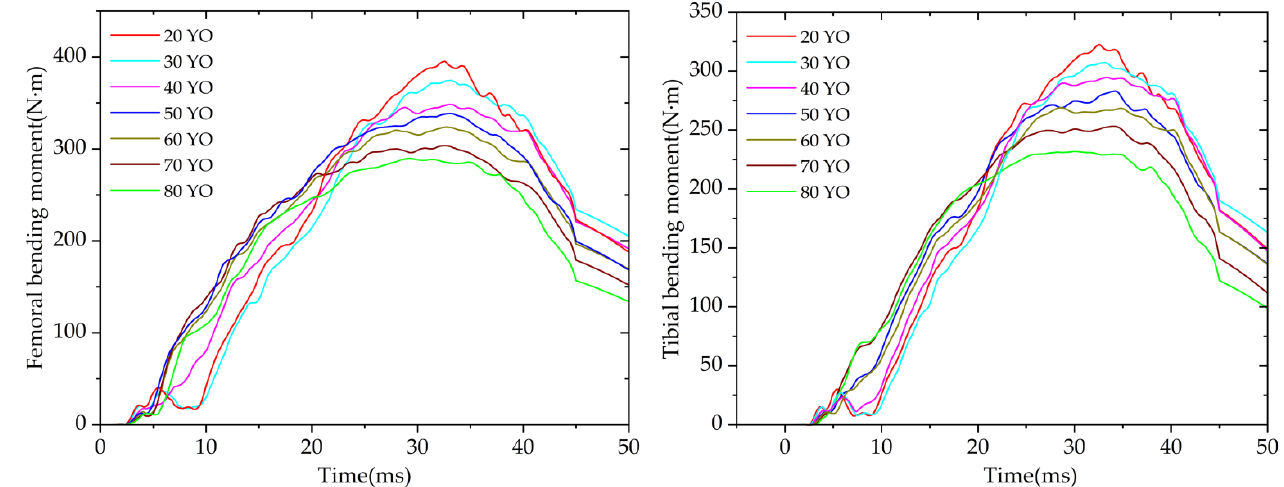
Figure A4. Bending moment of femur and tibia of pedestrians of seven ages at 60 km/h.